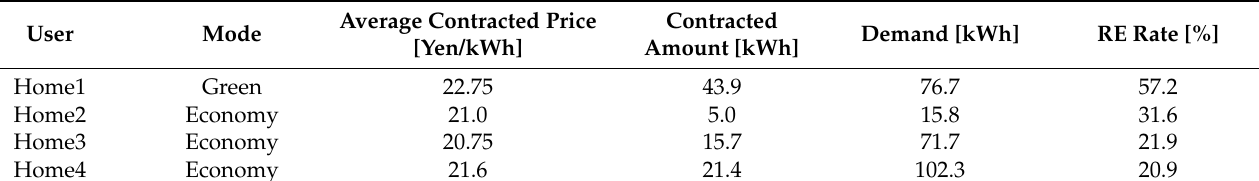
Table 4. Summary of trading results for the second week.